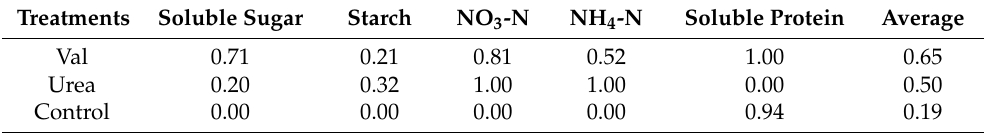
Table 3. Comprehensive effects of the different treatments on carbon and nitrogen accumulation.